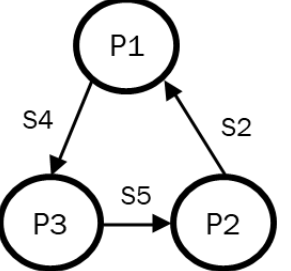
Figure 10. Graph diagram of the adjacency ordering for Scenario 2. Table 9. Map of indexes of the analysed surfaces and indexes of the vertexes of the surface for Scenario